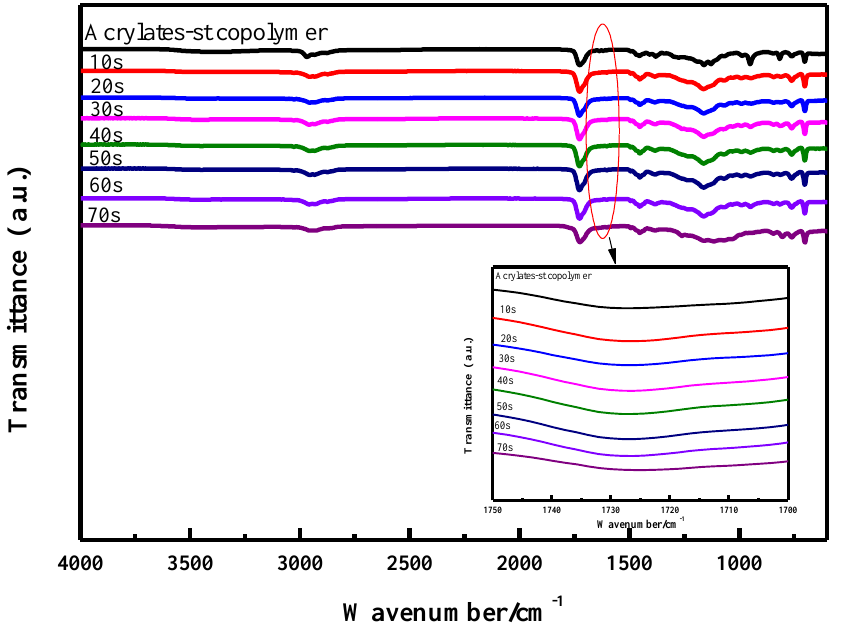
Figure 1. FT − IR spectra for copolymer of acrylate and styrene, the coatings cured for di ff erent times. Figure 1. FT−IR spectra for copolymer of acrylate and styrene, the coatings cured for different times.